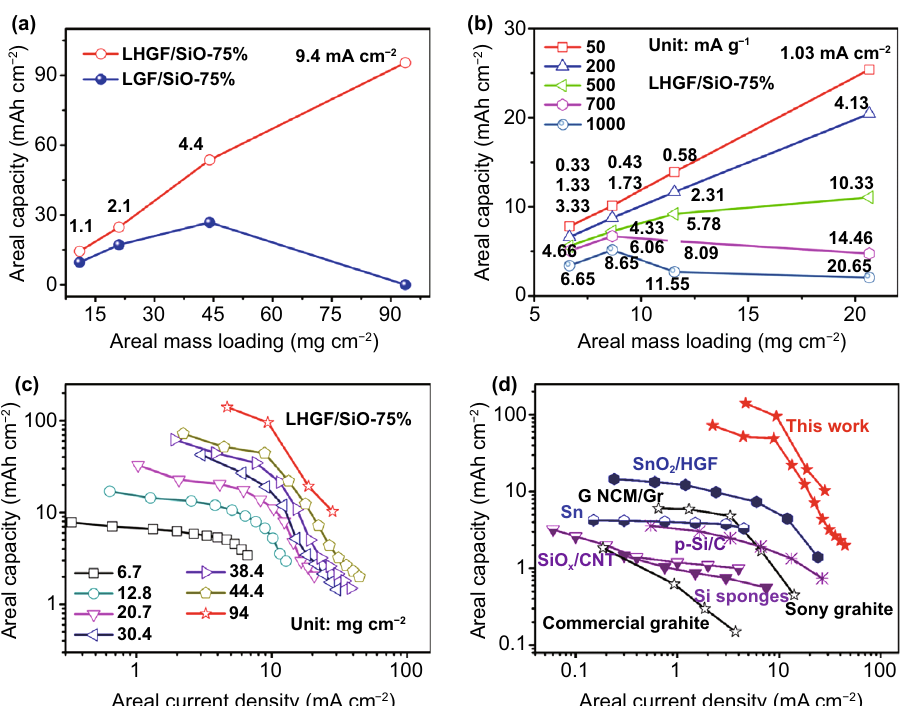
Fig. 5 The scaling relationship for increasing mass loadings and comparison of energy storage performance metrics for various anode materials. a Dependence of areal capacity on mass loading at 100 mA g −1 for the LHGF/SiO-75% and LGF/SiO-75% electrodes. b The areal capacity ver- sus mass loading for the LHGF/SiO-75% electrodes at various current densities. c The areal capacity versus current density for the LHGF/SiO- 75% electrodes at various mass loadings. d The comparison of areal performance metrics of LHGF/SiO-75% electrode with various research